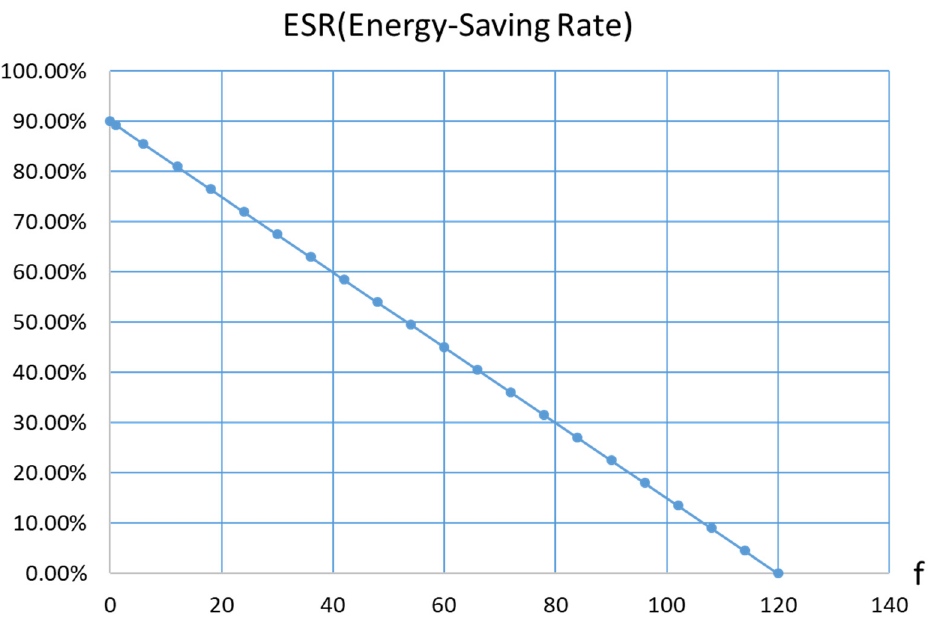
Figure 12. The relationship between ESR and f -value.